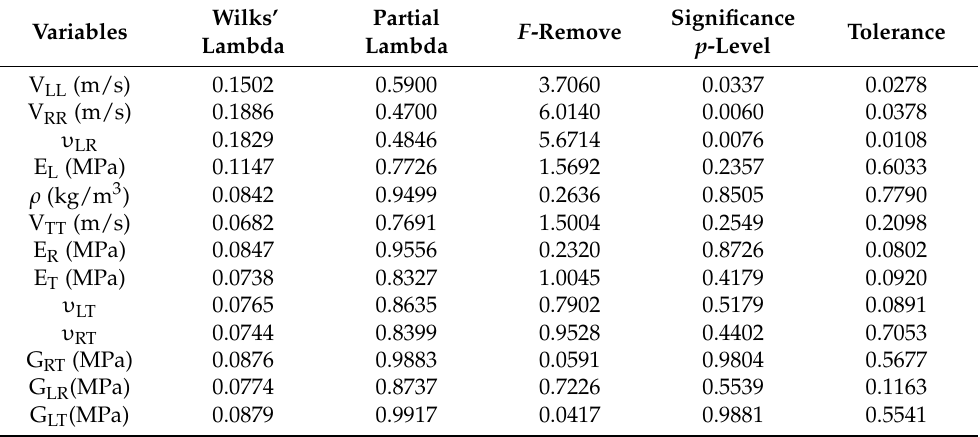
Table 6. The results of the multifactorial discriminant analysis of the acoustic and elastic parameters in relation to the music spruce wood